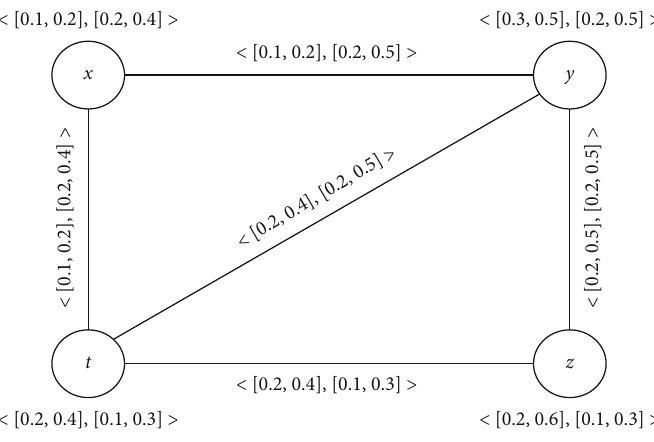
Figure 1: An IVIFG G for a strong node cover